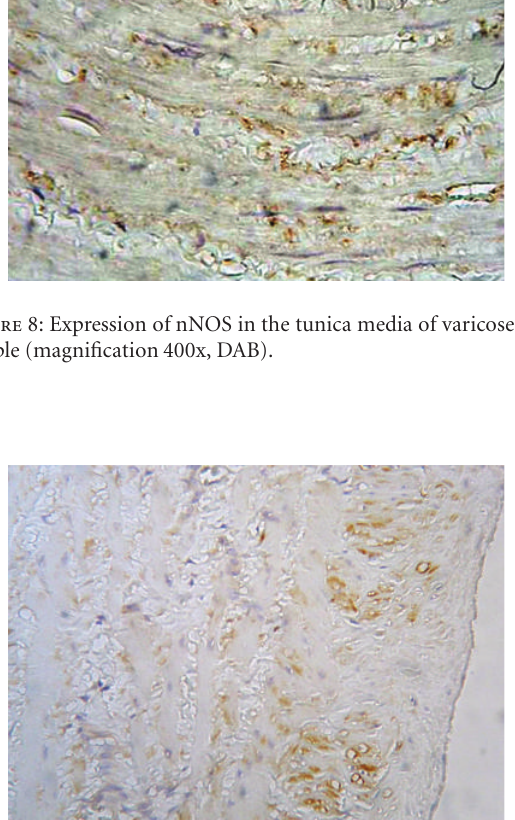
Figure 7: Expression of nNOS in the tunica media of control (healthy) vein sample (magnification 400x, DAB).